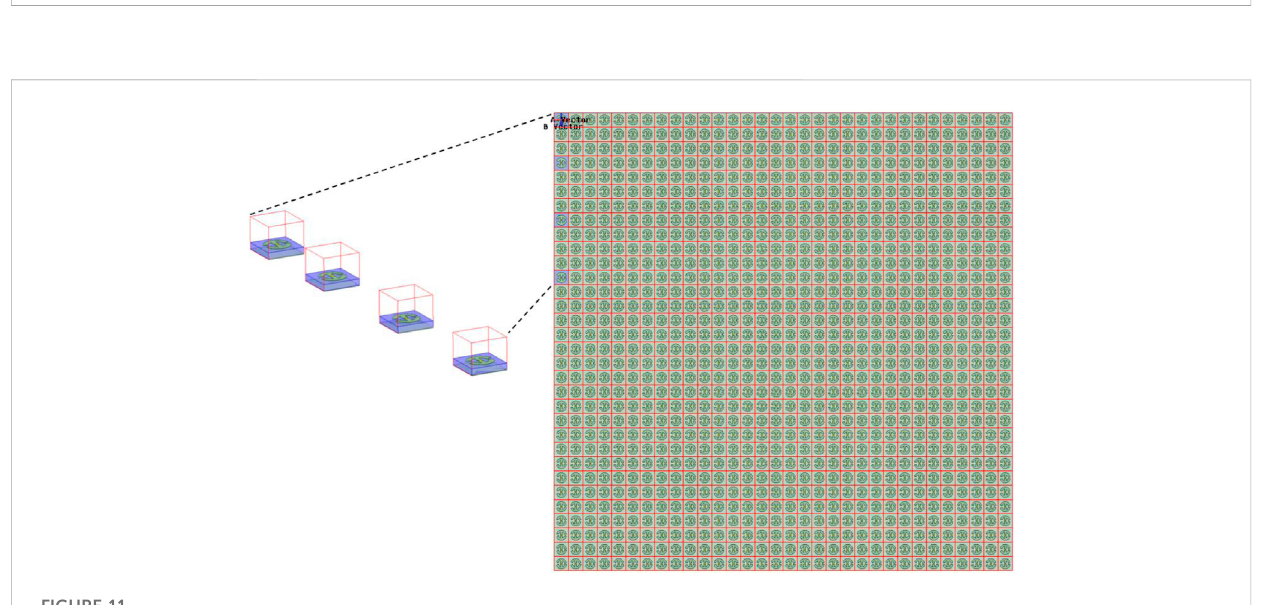
FIGURE 11 ANSYS HFSS model for the proposed RIS.